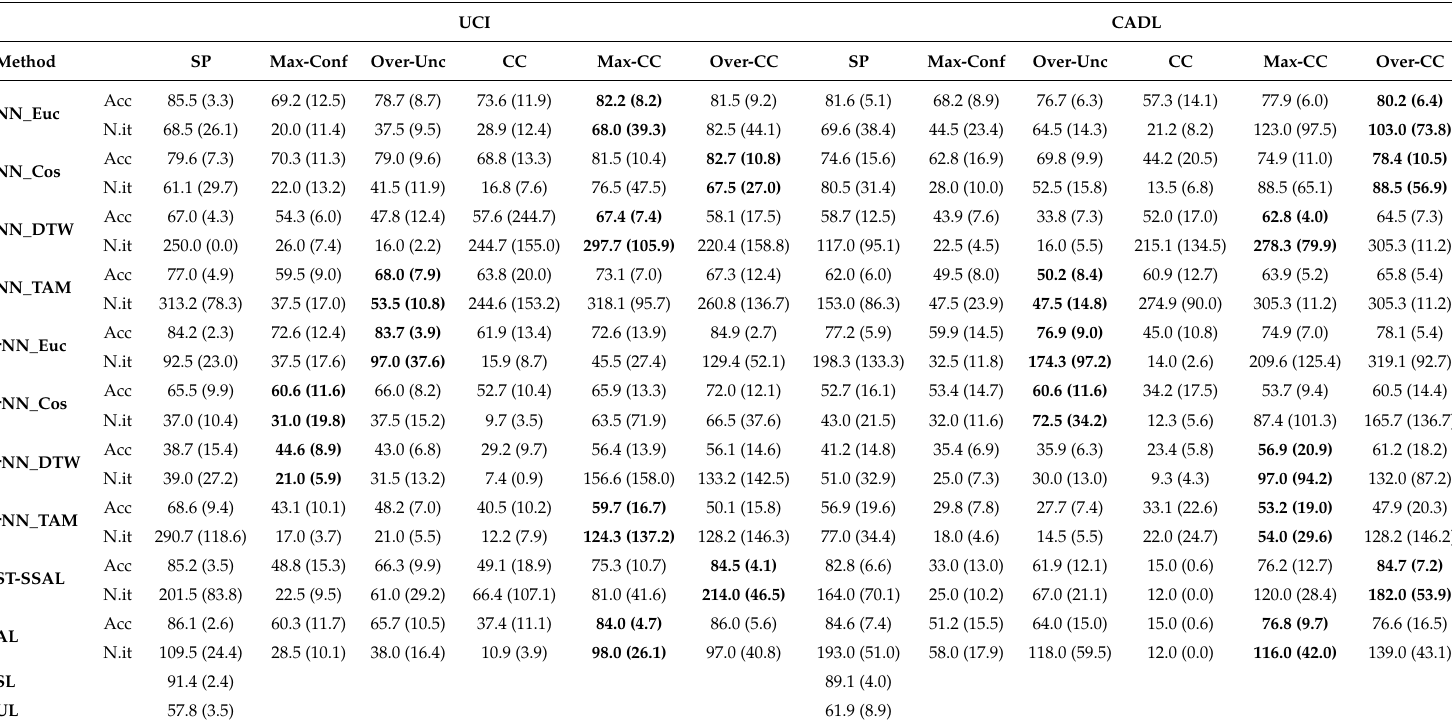
Table 5. SC methods accuracy and standard deviation average, acc (std) in percetage. Accuracy score denoted as Acc, and average iterations denoted as N.it over a 10-fold CV on the UCI and CADL datasets. Moreover, for each dataset, under the Stopping Point (SP) columns, the accuracy results in stabilisation are shown and below, the considered optimal number of iterations are shown. The most suitable method is shown in bold for each dataset.